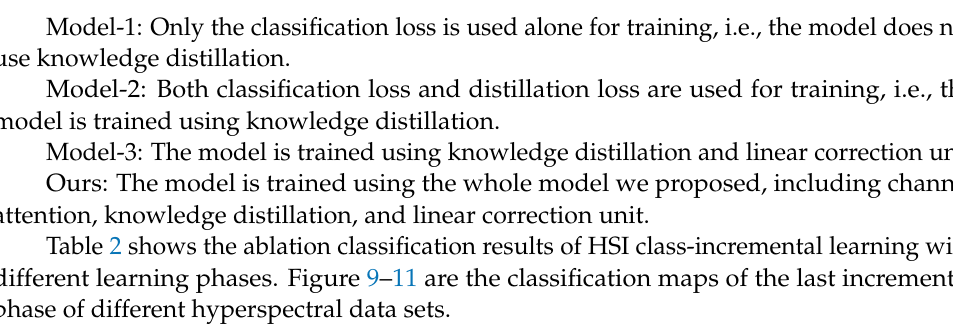
Table 2. Classification results of different HSIs and different models. Model Meas.